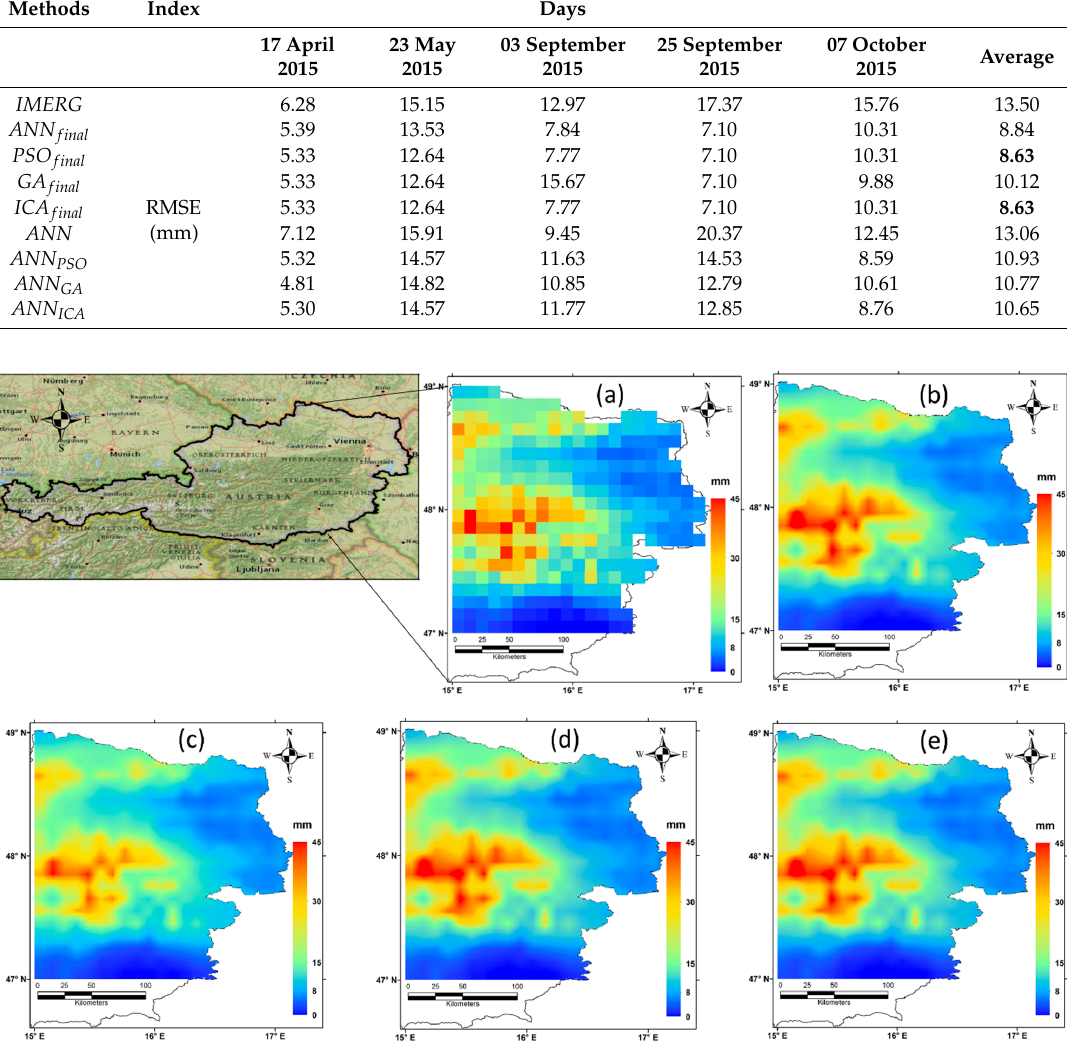
Figure 8. ( a ) Original Integrated Multi-satellite Retrievals for GPM; Global Precipitation Measurement (IMERG) and the final downscaled products through ( b ) ANN, ( c ) GA, ( d ) ICA, ( e ) PSO for 23 May 2015 event over Northeast Austria. Table 7. Evaluation statistics for all final downscaled products for the selected events over Northeast Austria. Meth